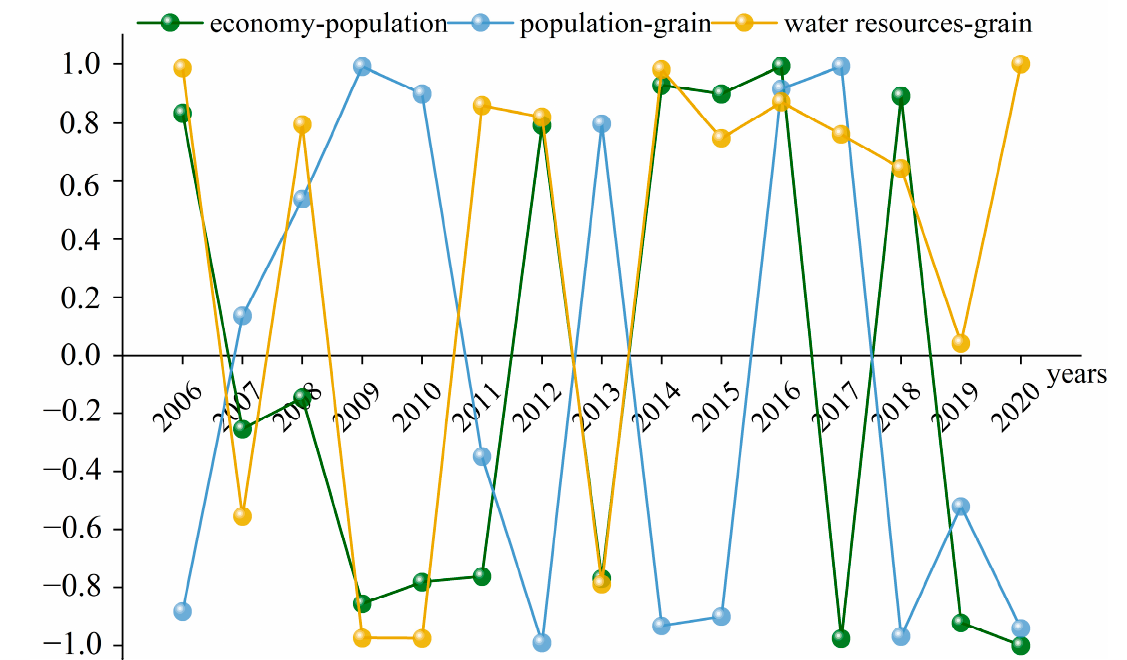
Figure 11. Variation consistencies in two factors in the Tarim River Basin.